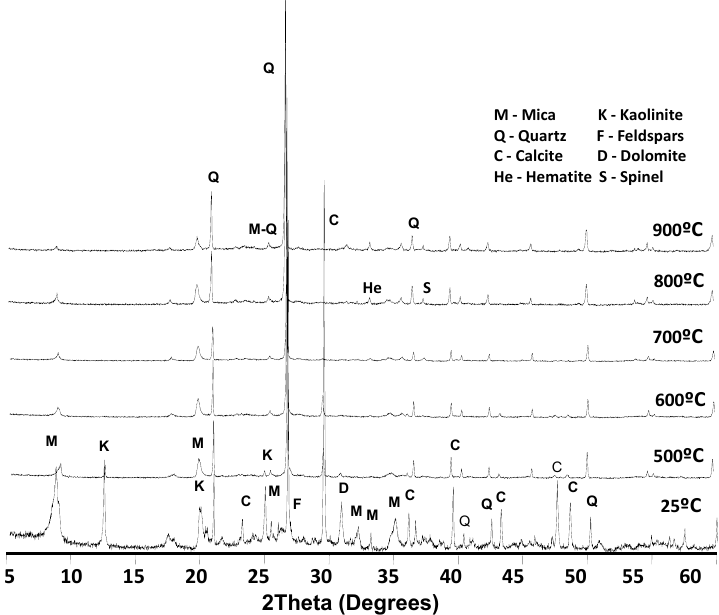
Figure 1. Mineralogical composition by X-ray diffraction (XRD) for the coal mining waste and the coal mining activated waste.